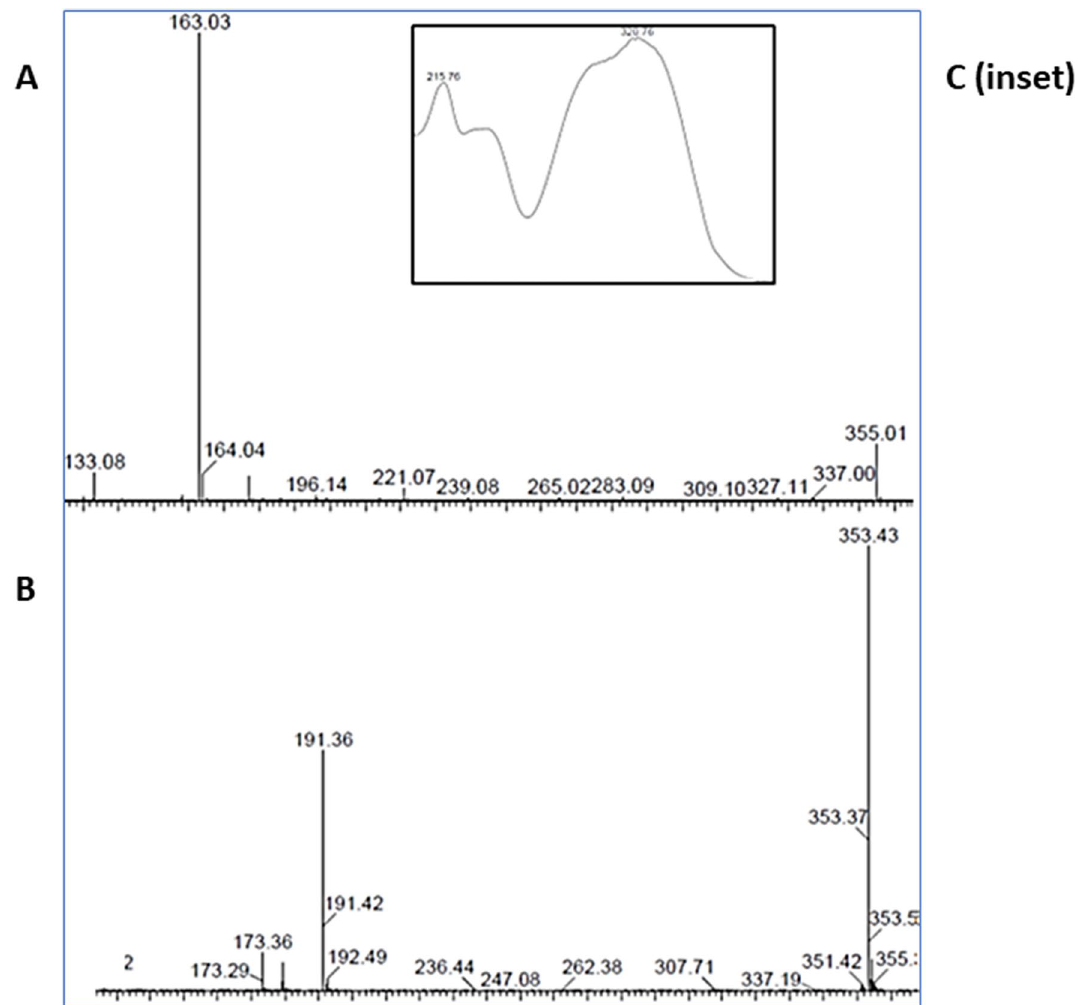
Figure 7. Representative MS and UV spectra of Fraction “K” containing chlorogenic acid and cynarine. ( A ) ESI + mass spectra. ( B ) ESI—mass spectra. ( C ) UV